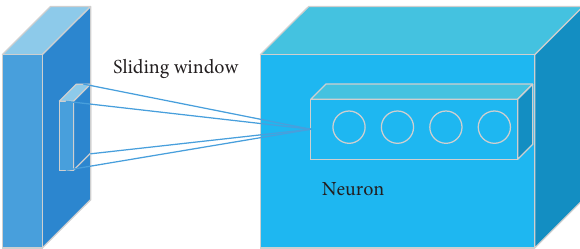
Figure 2: Convolution transformation